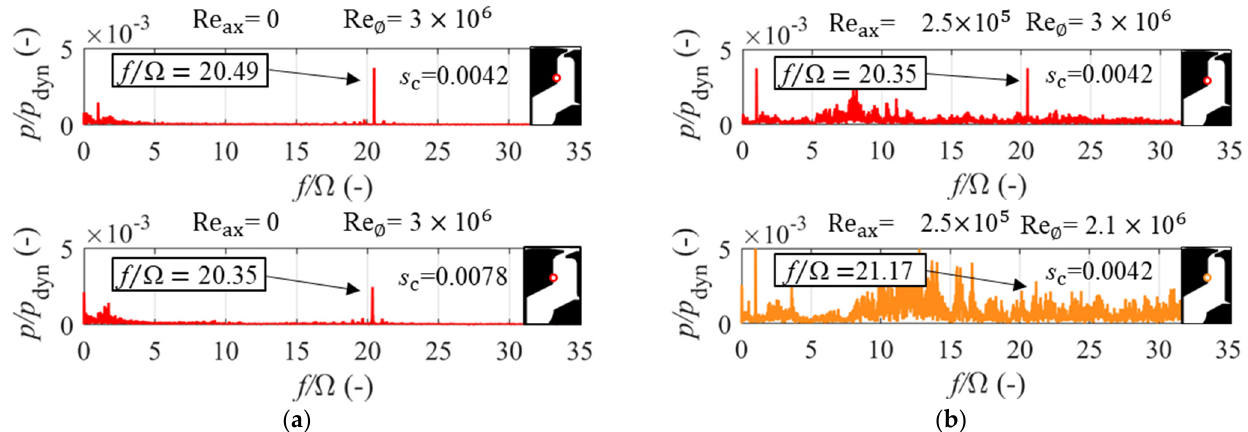
Figure 9. Frequency spectra of the unsteady pressures at C w = 3500, r/b = 0.95 in ( a ) absence of annulus flow at constant rotational Reynolds number for two seal clearances and ( b ) with axial axisymmetric annulus flow at constant gap size for two rotational Reynolds numbers.